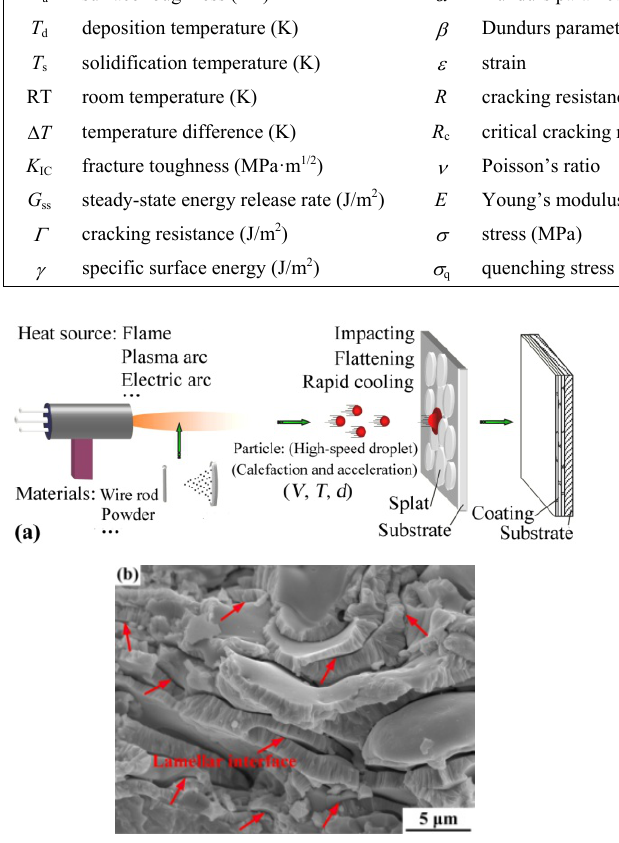
Fig. 1 (a) Schematic diagram of thermal spray technology [11] and (b) typical cross-sectional microstructure of thermally sprayed 7YSZ coatings. The red arrows in (b) denote the inter-splat lamellar interfaces which are ubiquitous in thermally sprayed